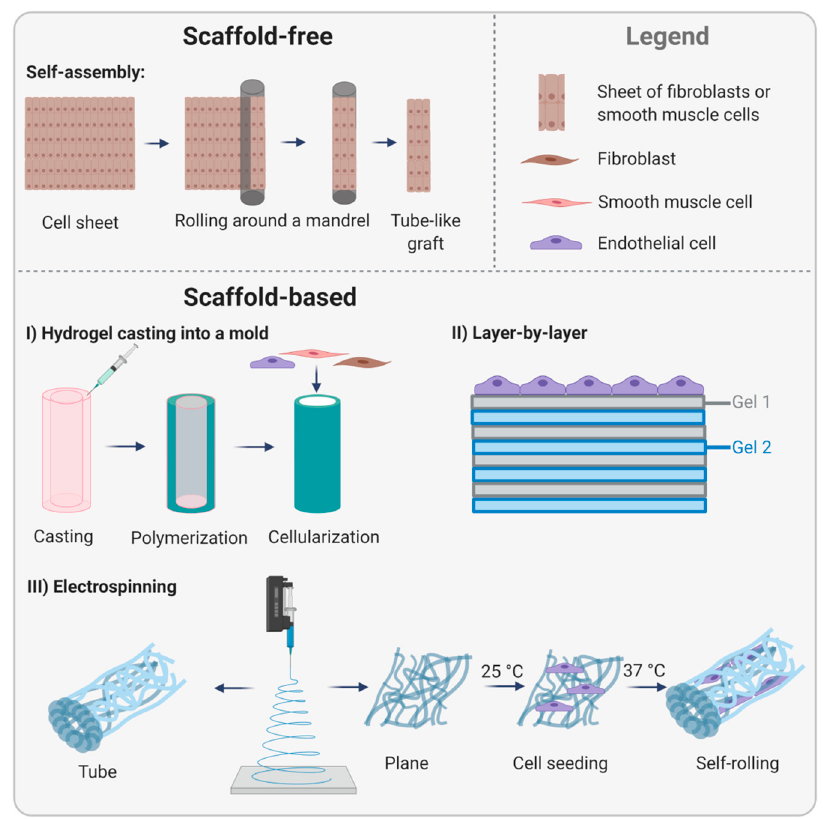
Figure 7. Tissue engineering-based strategies to mimic the endothelial basement membrane (EBM). A scaffold-free method based on cellular self-assembly and three different scaffold-based ap- proaches are shown. The latter comprises hydrogel casting into a mold, hydrogel polymerization, scaffold removal and graft cellularization (I), layer-by-layer stacking of two different hydrogels and EC cultivation on top (II), and electrospinning of either tubular grafts or fabrication of plane sheets with shape-memory polymers, which self-roll into tube-like constructs at a specific temperature (III).